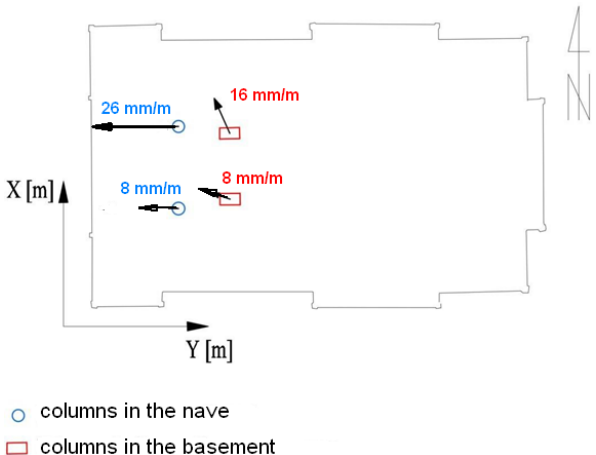
Figure 11. Determined vectors of inclination of the column axes from the vertical.